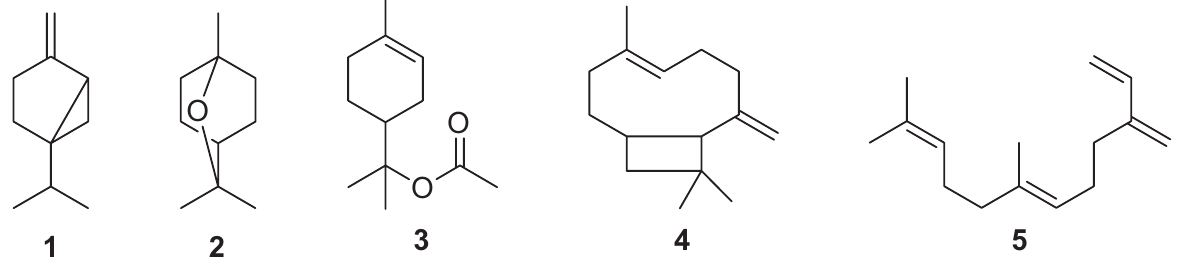
Figure 1 - Chemical structures of the monoterpenes sabinene ( 1 ), 1,8-cineole ( 2 ), α-terpinyl acetate ( 3 ), ( E )-caryophyllene ( 4 ), and ( E )-β-farnesene ( 5